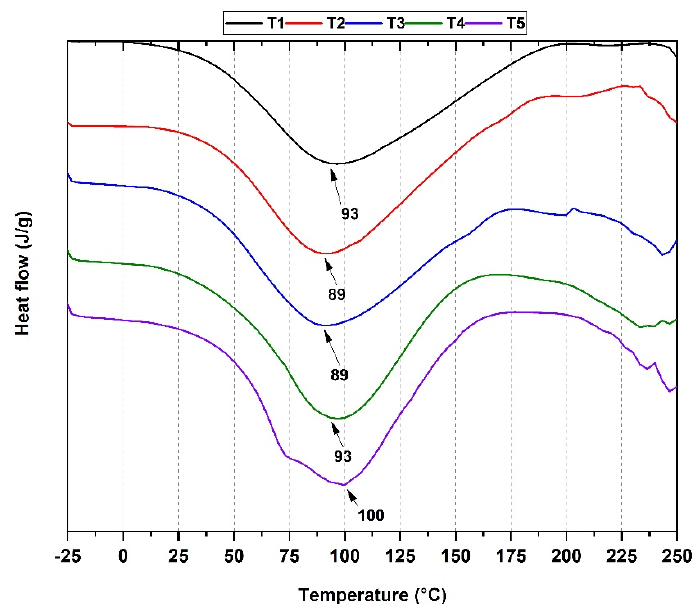
Figure 3. DSC analysis of the five (T1 − T5) composites. T1 (100%CS); T2 (25%G:75%CS); T3 (50%G:50%CS); T4 (75%G:25%CS); T5 (100%G).